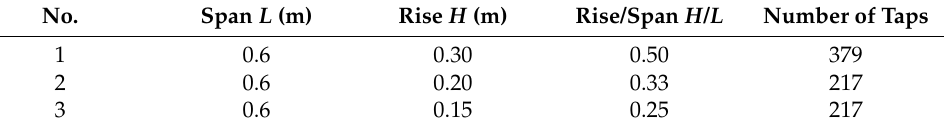
Table 2. Detailed parameters of the experiment models.